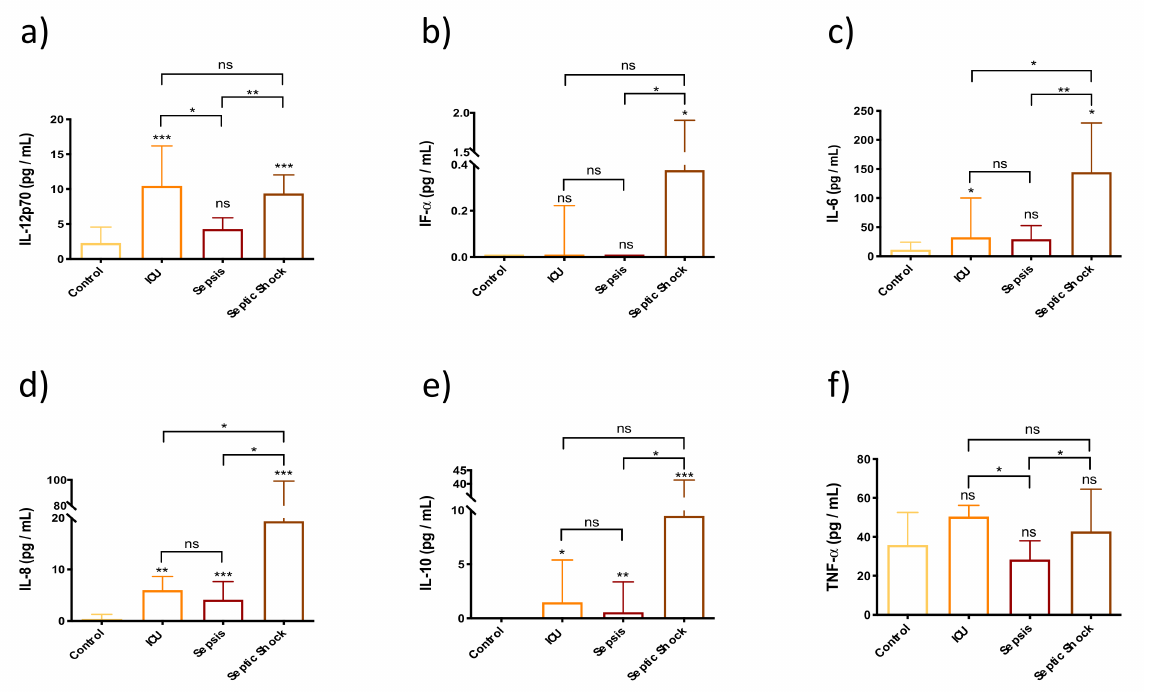
Figure 3. Bar graph (Median ± IQR) of circulating levels of cytokines activating macrophages and NK cells, in control group, ICU, sepsis and septic shock patients. ( a ) Circulating levels of IL- 12p70; ( b ) Circulating levels of IFN- α ; ( c ) Circulating levels of IL-6; ( d ) Circulating levels of IL-8; ( e ) Circulating levels of IL-10; ( f ) Circulating levels of TNF α . Each sample was measured in duplicate. ns = non-significant p value; * p < 0.05; ** p < 0.01; *** p < 0.001. The lines at the top of the box plots indicate differences between compared conditions. The number of subjects analyzed were as follows: control ( n = 10); intensive care unit (ICU) ( n = 5); sepsis ( n = 10); septic shock (SS) ( n =